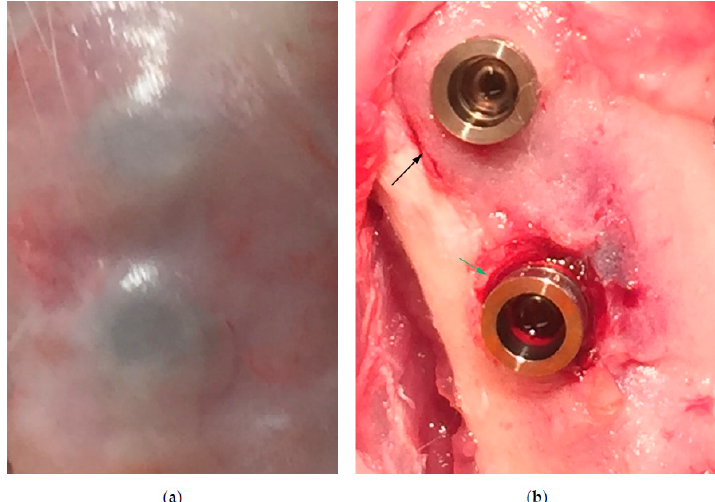
Figure 3. ( a ) The soft tissue covering a tibial control implant (superior) and test implant (inferior) after removal of skin and subcutaneous tissues. ( b ) A small saucerization-like defect (green arrow) visible after